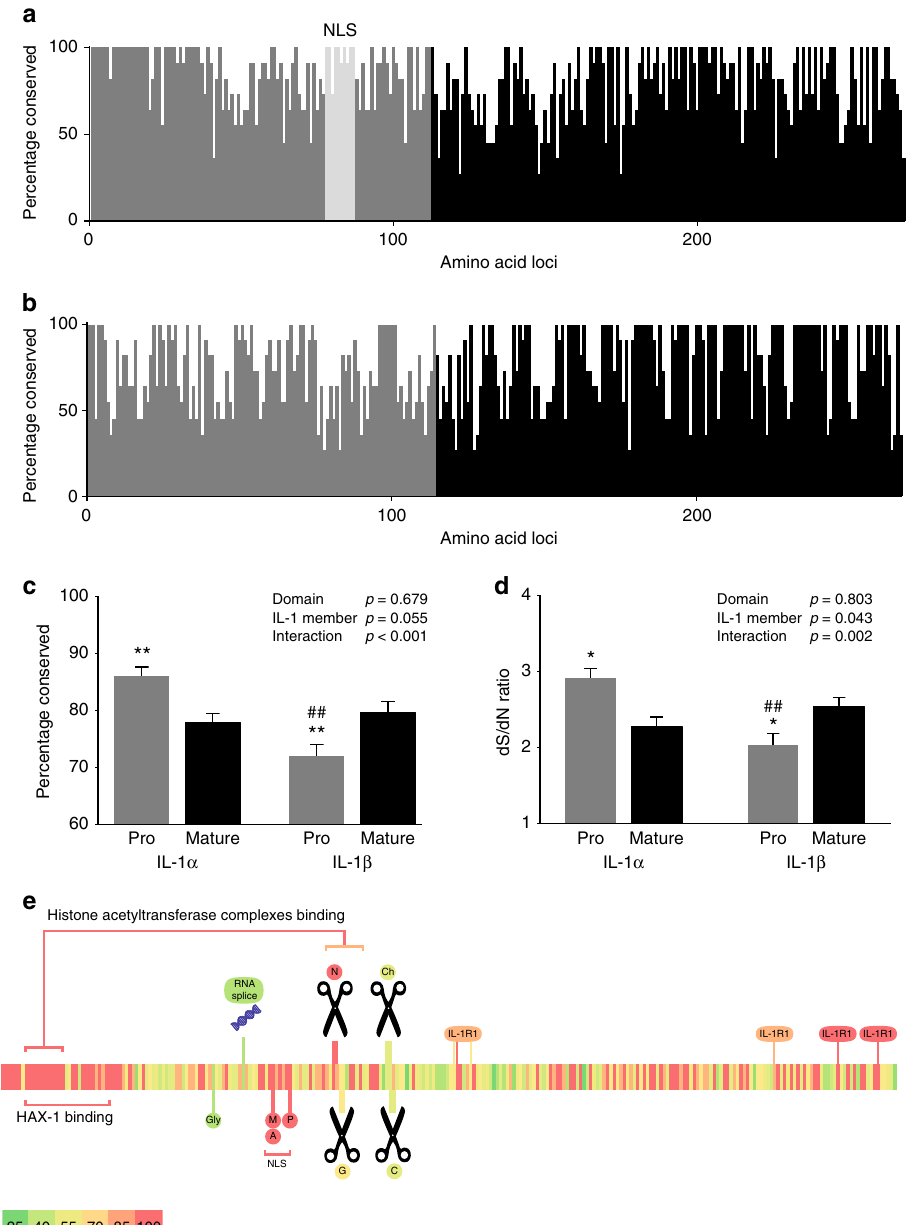
Fig. 3 Conservation of IL-1 α and IL-1 β sequences in mammals. The percentage of conserved a.a. residues of the pro (grey) and mature (black) segments of IL-1 α ( a ) and IL-1 β ( b ). c The average conservation from a , b showing that the amino acid sequence of the pro-domain of IL-1 α is highly conserved, more so than the mature domain of either IL-1 α or IL-1 β . d The ratio of synonymous (dS) to non-synonymous (dN) substitutions per potential substitution site demonstrates strong positive selection for the conserved pro-domain of IL-1 α . Analyses were conducted using the Nei-Gojobori method 80 . e A heat map of the conservation of IL-1 α sequence across mammalian species depicting the correlation with putative functions of the IL-1 α protein (green 25% conserved to red 100% conserved across mammalian species). The NLS sequence, histone acetyltransferase complex-binding region, HAX-1-binding region, neutrophil elastase cleavage site (N) and NLS post-translation modi fi cation sites were very highly conserved (P, phosphorylation; A, acetylation; M, myristoylation), while the glycosylation (gly) site, RNA splicing domain and cleavage sites for chymase (Ch), caspase-1 (C), and granzyme B (G) were poorly conserved. c , d bars are means ± SEM, * p < 0.05 and ** p < 0.01 pro-domain vs mature domain within IL-1 member; # p < 0.05 and ## p < 0.01 IL-1 β vs. IL-1 α within domain, omnibus effects evaluated by linear modelling followed Sidak correct post-hoc